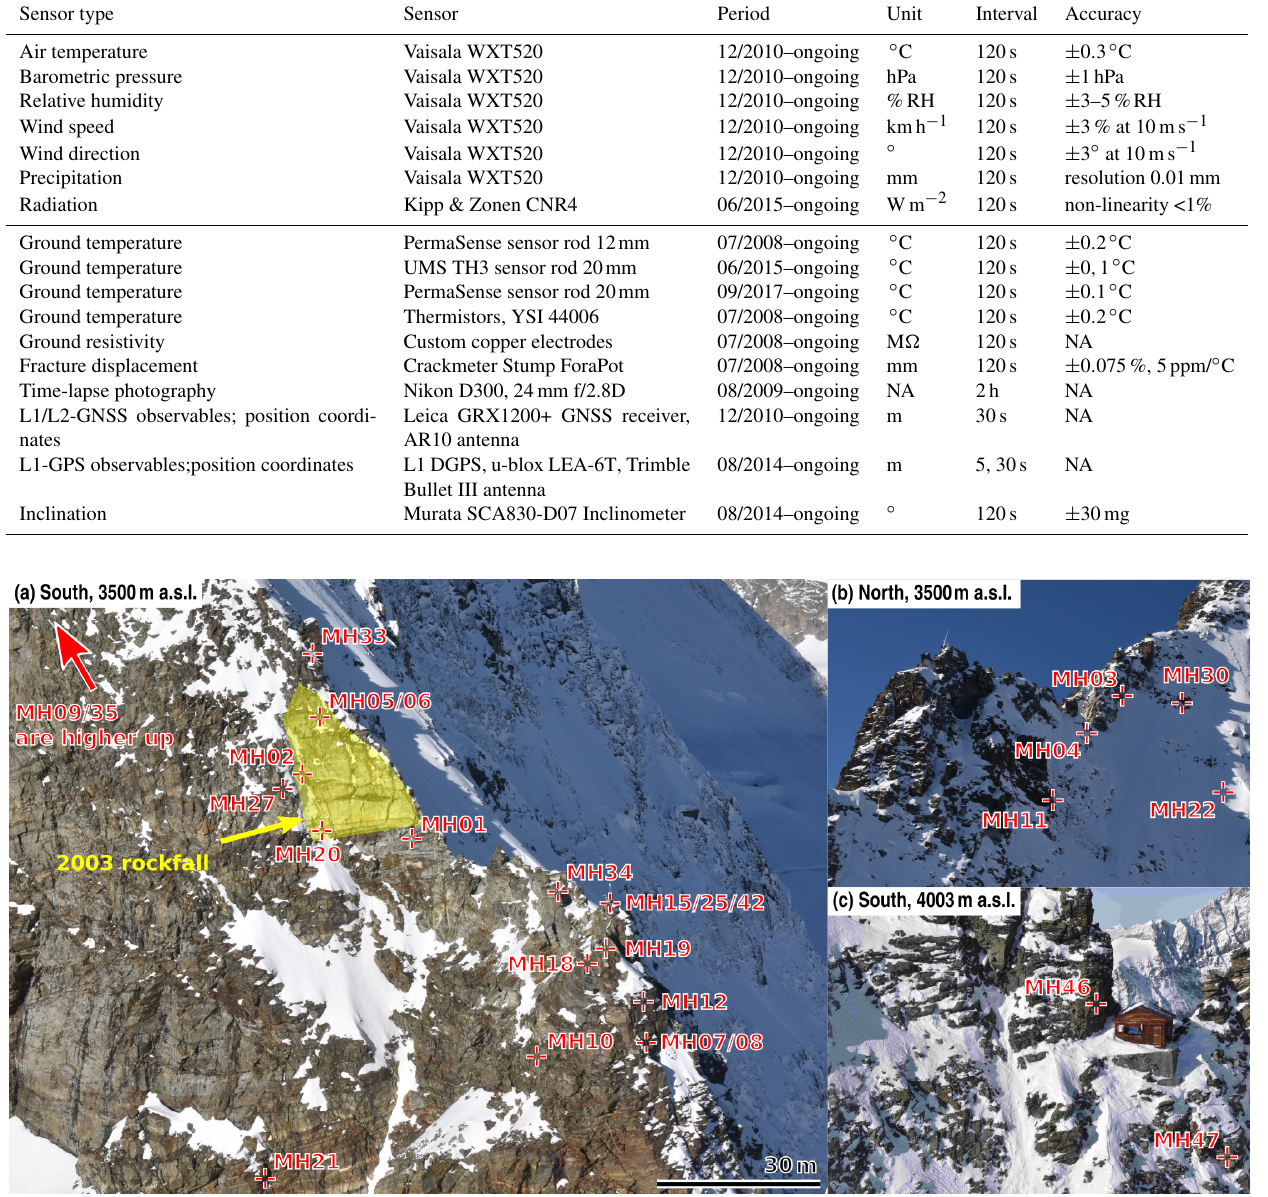
Figure 5. Overview of the field instrumentation at the Matterhorn Hörnligrat: (a, b) southern and northern sides on approximately 3500ma . s . l . next to the 2003 rockfall event. (c) Extension next to the Solvay Hut at 4003ma . s . l . with southern